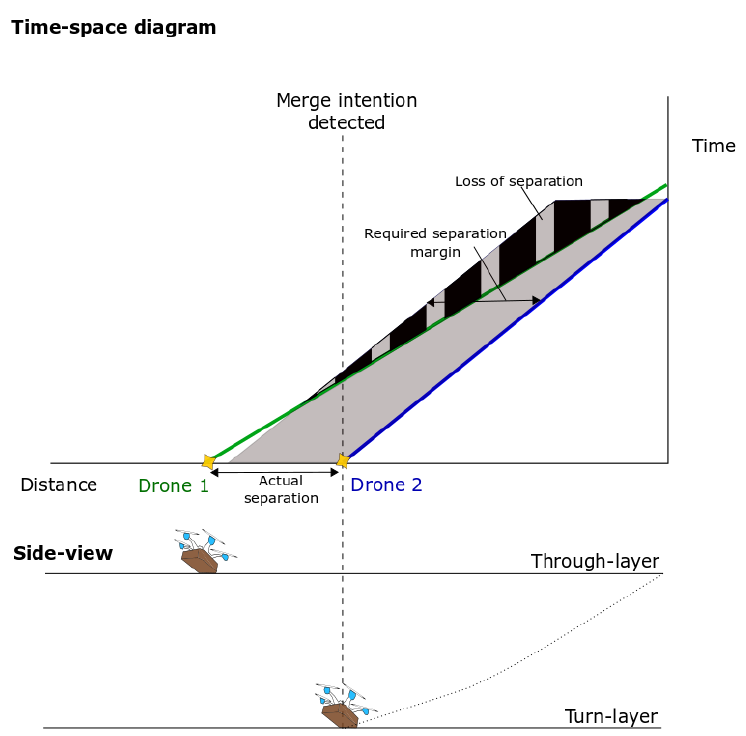
Figure 2. Example of a time–space representation for a pair of drones. The flight trajectories of drone 1 and drone 2 are represented by the green and blue lines. The grey area denotes the required separation margin, while the shaded area depicts a separation violation. To maintain safe separation, the trajectories need to be within or outside the required separation margin (grey area). Note that a side-view is only included for purpose of